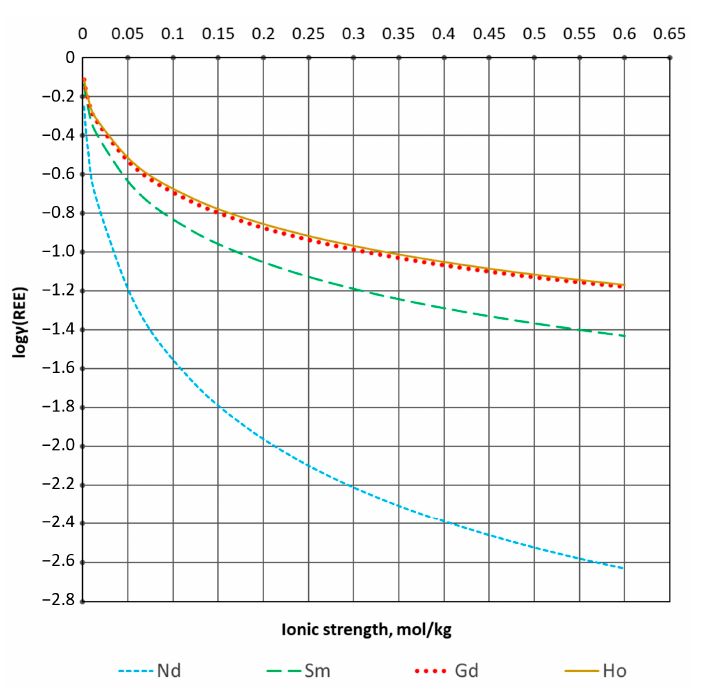
Figure 4. Dependence of concentration of REE complexes on ionic strength. Comparing the equilibrium constants obtained in the experiment with the thermodynamic data [20], signi fi cant di ff erences can be noted. The equilibrium constant of reaction (6) is the smallest, while reaction (7) has the highest equilibrium constant. This